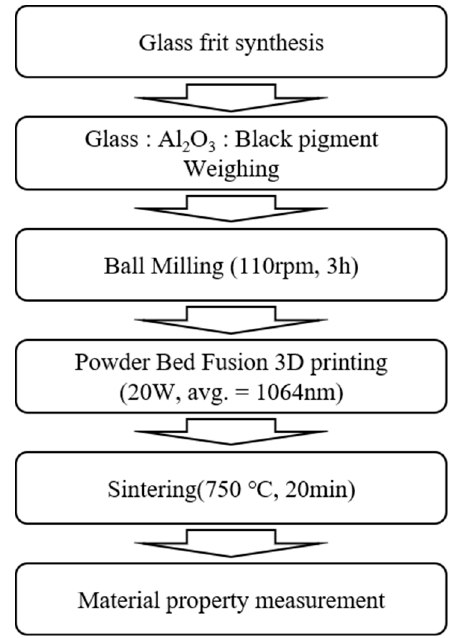
Figure 2. Process flow for glass/Al 2 O 3 composite fabrication and property measurement.